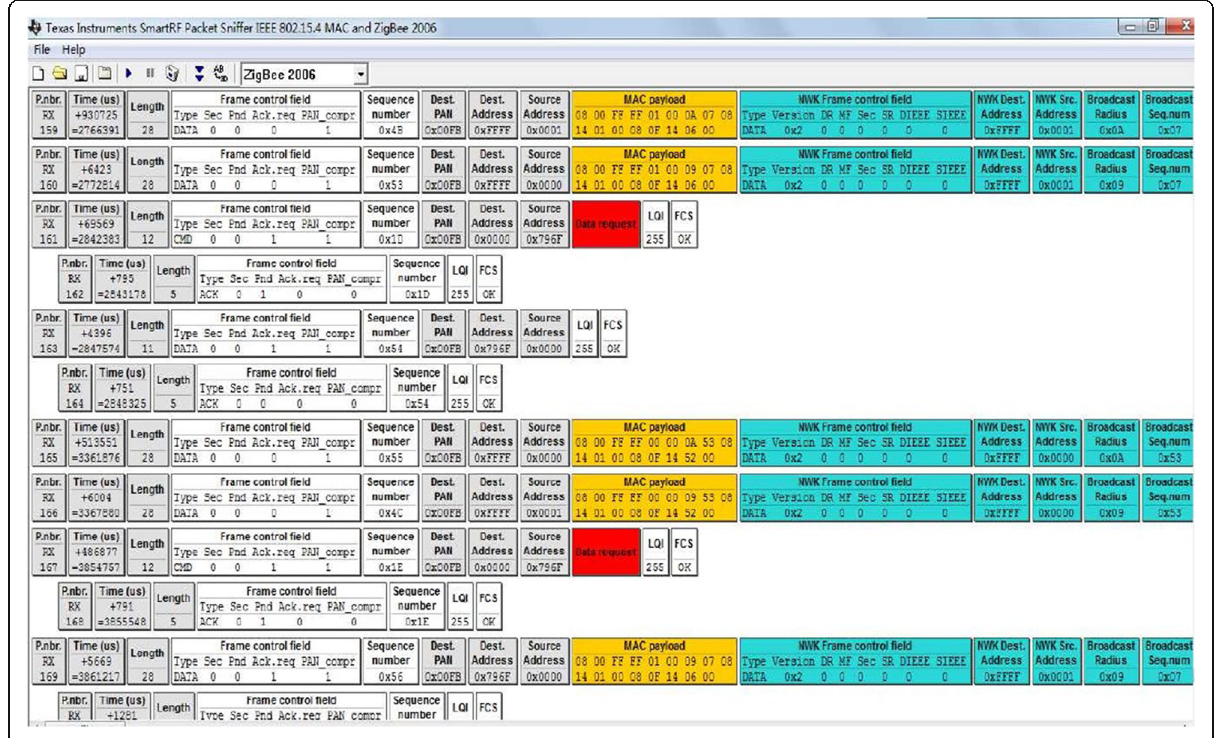
Fig. 8 ZigBee network generation